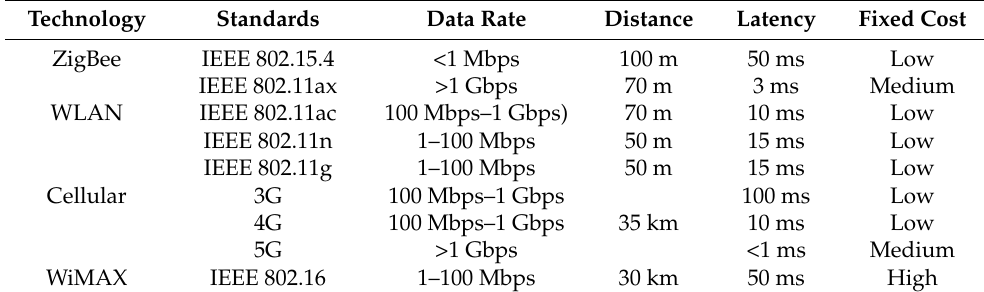
Table 2. Summary of wireless technologies for cooperative control [107].